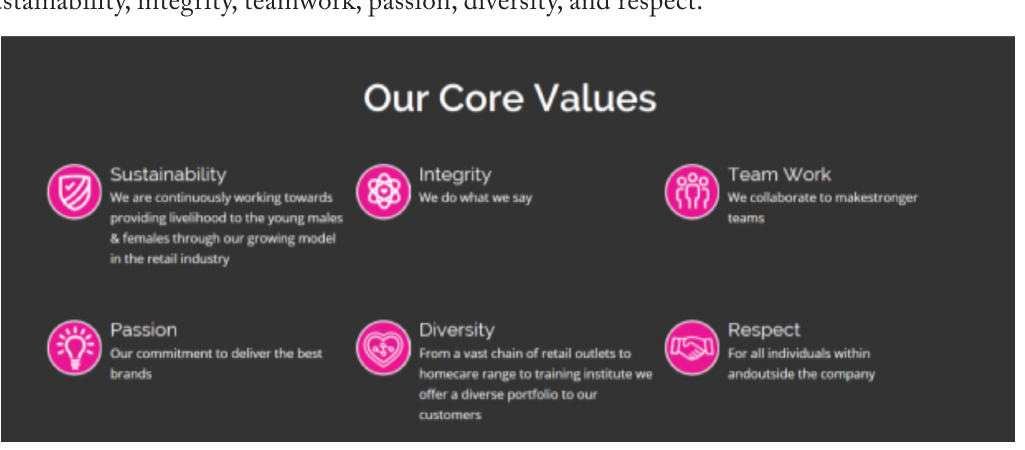
Figure 1: Core values of Bays International; Source: Bays Internatinal